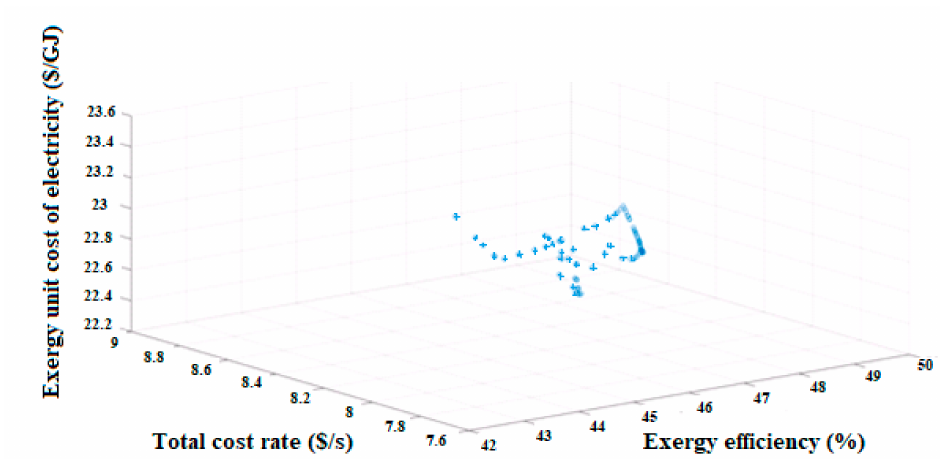
Figure 15. Pareto optimal solutions for the configuration shown in Figure 2.